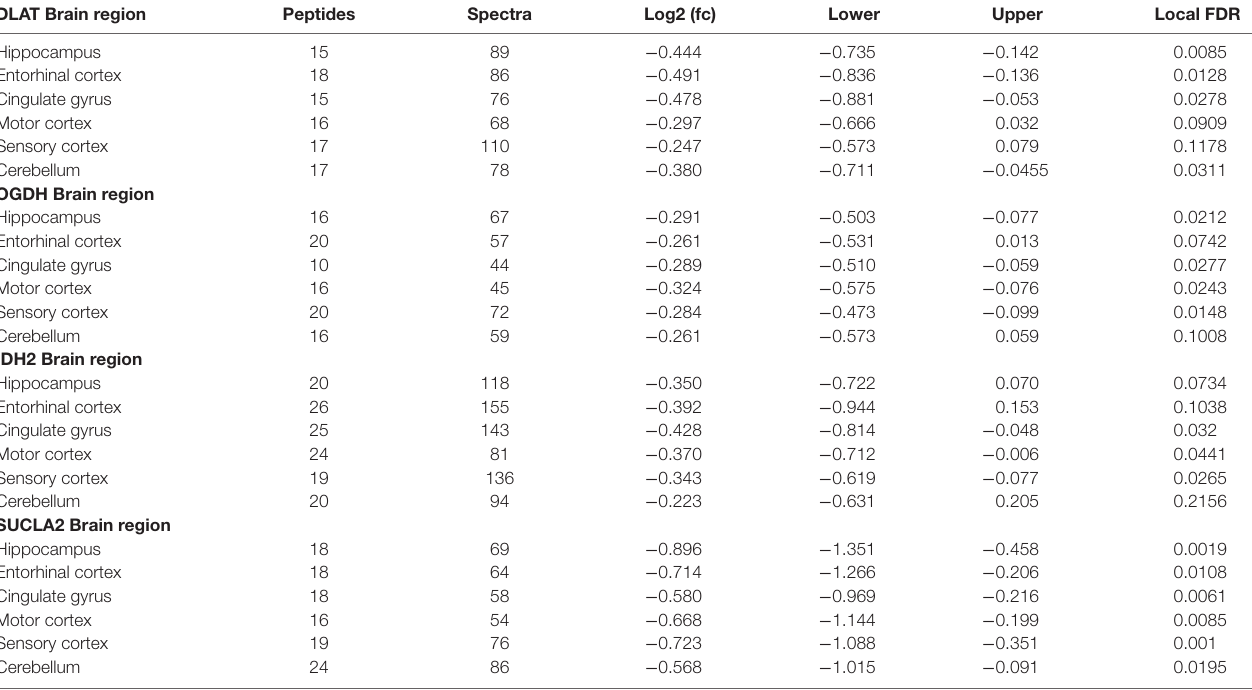
TABLE 3 | Multiregional Bayesian-differential quantification for cerebral dihydrolipoyl transacetylase, 2-oxoglutarate dehydrogenase, mitochondrial isocitrate dehydrogenase and the α subunit of the succinyl-CoA synthetase expression. DLAT Brain